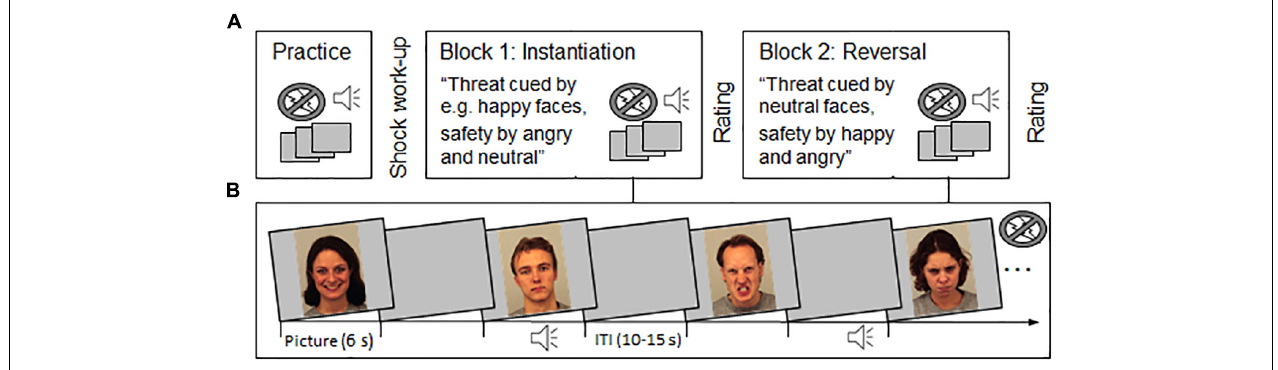
FIGURE 1 | Schematic illustration of the experimental procedure (A) and stimulus presentation (B) . (A) A brief practice run and shock work-up procedure preceded the experiment. In the first experimental block (instantiation), participants were verbally instructed that one particular emotional facial expression signals threat-of-shock (e.g., happy) or safety (e.g., angry and neutral faces). The second experimental block (reversal), started with a verbal reversal instruction stating that now threat and safety contingencies are reversed. Now neutral faces cued shock threat in both experimental groups, and happy and angry faces signaled safety in Block 2. The order in which facial expressions cued threat (happy–neutral or angry–neutral) was tested in two groups of each N = 20. After each block, threat and safety cues were rated regarding valence, arousal, and perceived threat. (B) During the experimental blocks, happy, neutral and angry face pictures were presented (each 6 s) with a variable inter-trial interval (ITI, 10 to 15 s). In total, 24 pictures were presented together with an auditory startle probe (and six ITI startles), which were equally distributed across experimental conditions. No shocks were presented during the experiment. Example pictures are taken from the KDEF with permission (identifiers: af01has, am08nes, am10ans, and af20ans; see Lundqvist et al., 1998;